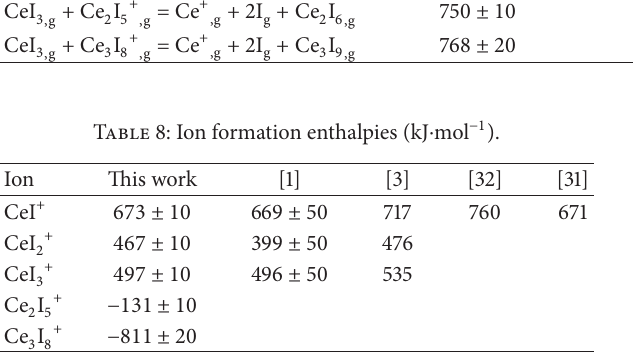
Table 9: Formation enthalpies of CeI 3,